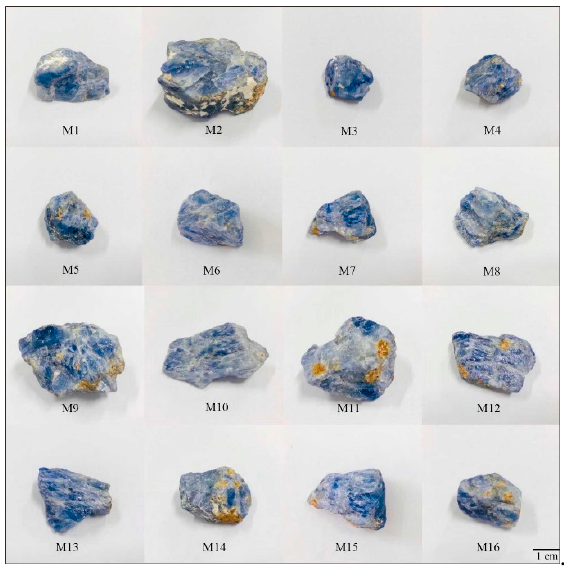
Figure 2. Rough sapphires from Baw-mar Mine.